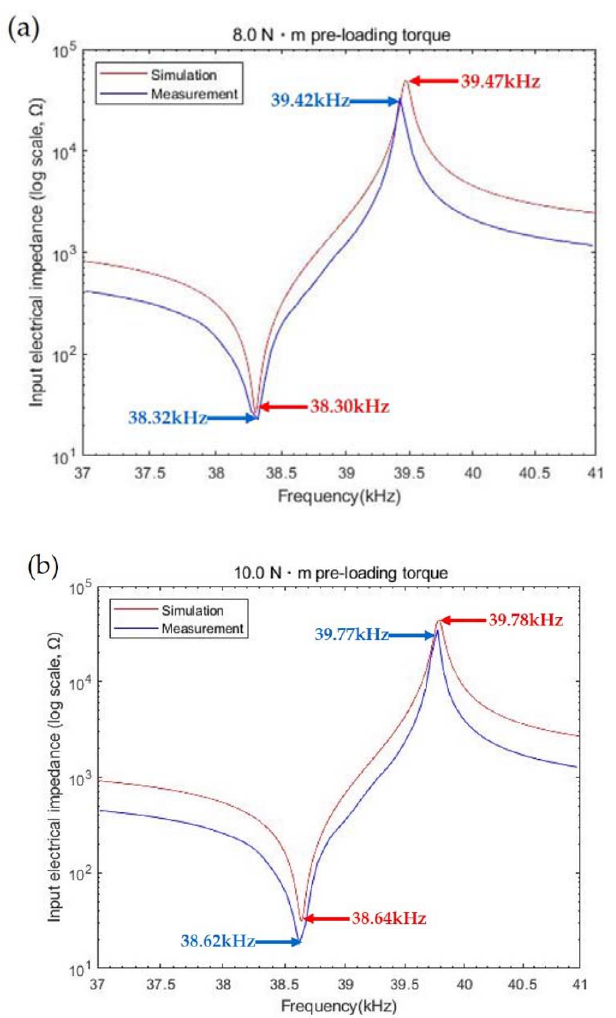
Figure 4. Comparison between simulation and test results for ( a ) 8.0 N ‧ m and ( b ) 10.0 N ‧ m.